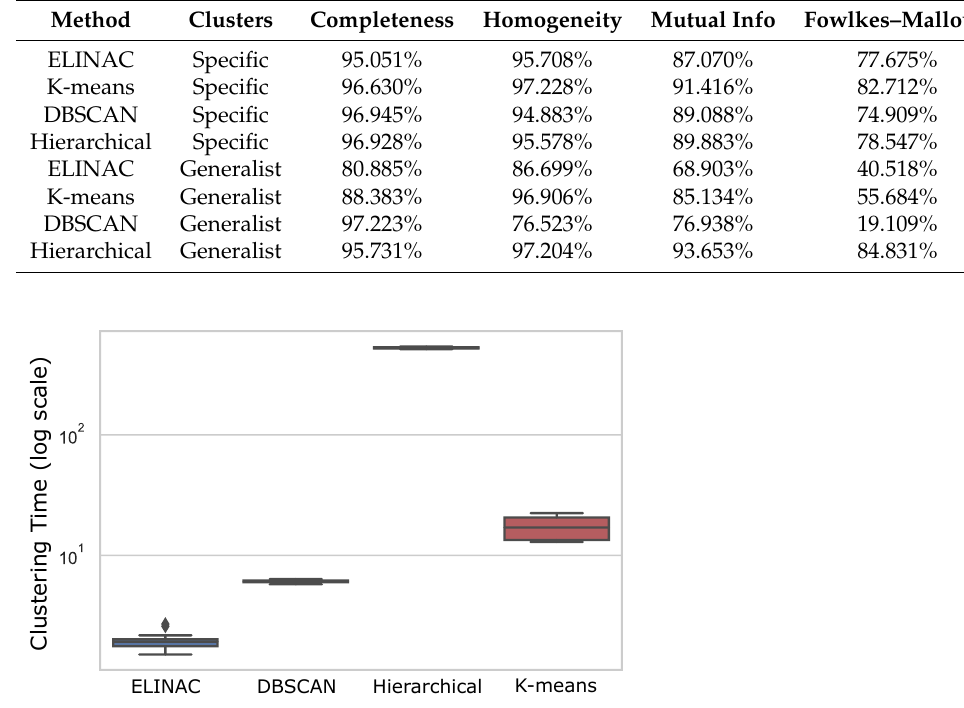
Figure 10. Spread of the clustering time on a logarithmic scale for generalist and specific